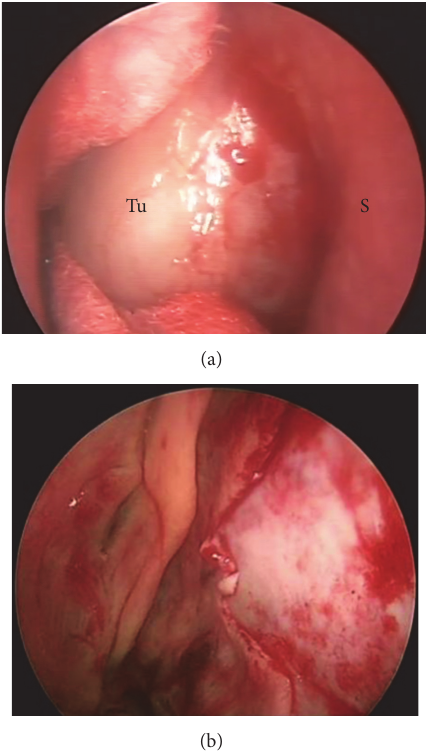
Figure2:Endoscopicappearance.Preoperative(a)andimmediately after resection (b). Tu = tumor. S = nasal